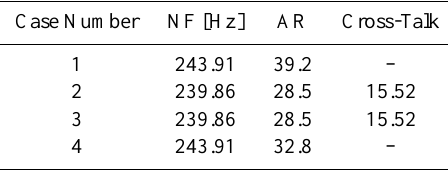
Table 4. Design parameters and their range used for optimization (unit: mm).